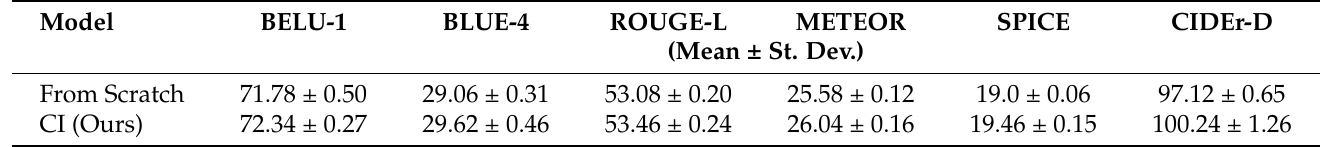
Table 4. Metric evaluation of vanilla image captioning models. Training eight times for each